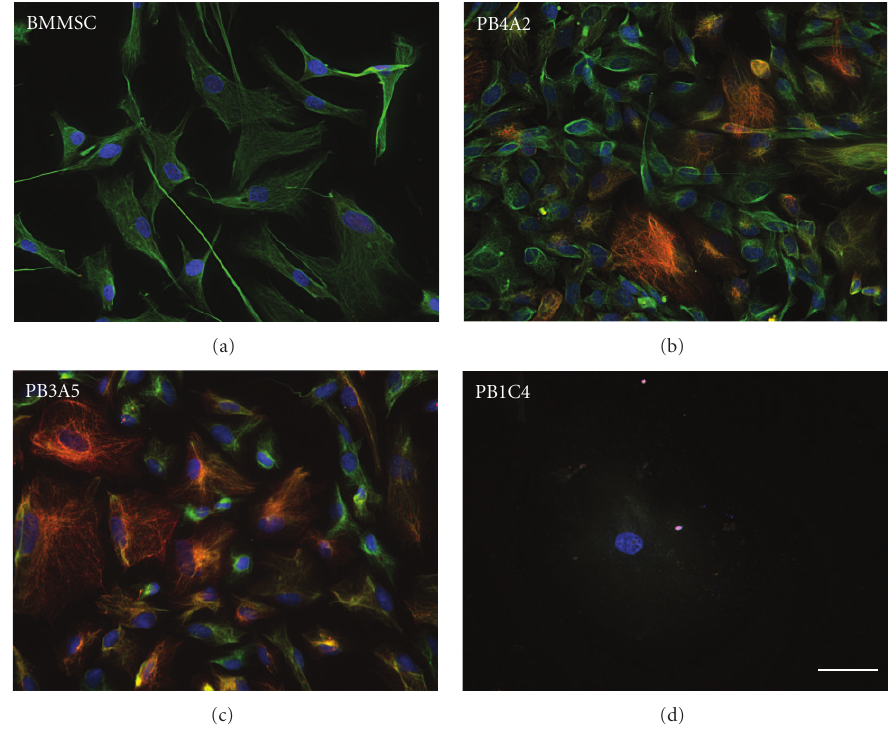
Figure 5: Immunostaining for vimentin and keratin. BMMSCp5, PB4A2p16, PB1C4p12 and PB3B5p11 cell populations were stained for the stromal cell marker vimentin (green), the epithelial cell marker keratin (red) and a fluorescent chromatin dye (blue). Note that virtually all PB4A2 and PB3B5 cells showed keratin staining, although the intensity varied. The clonal population of PB1C4 stromal progenitors did not show immunostaining of prominent networks of either vimentin or keratin. Scale (50 microns) is identical in all